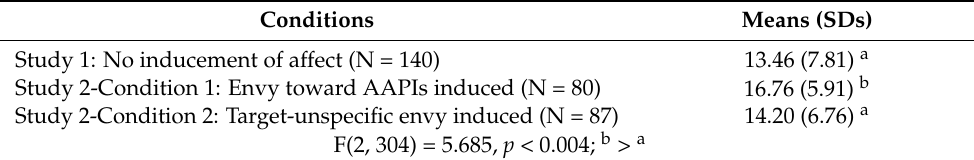
Table 5. Comparison of the mean Coronavirus Asiaphobia scores across two studies.